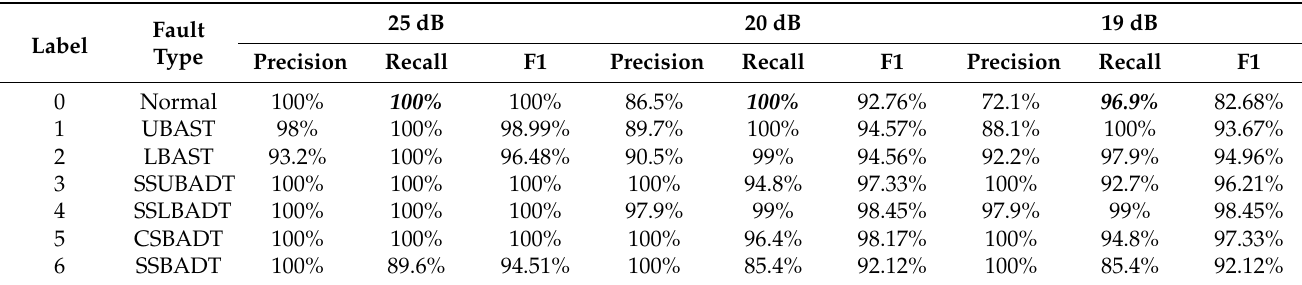
Table 5. Comparison of Res-BiLSTM performance indexes under different